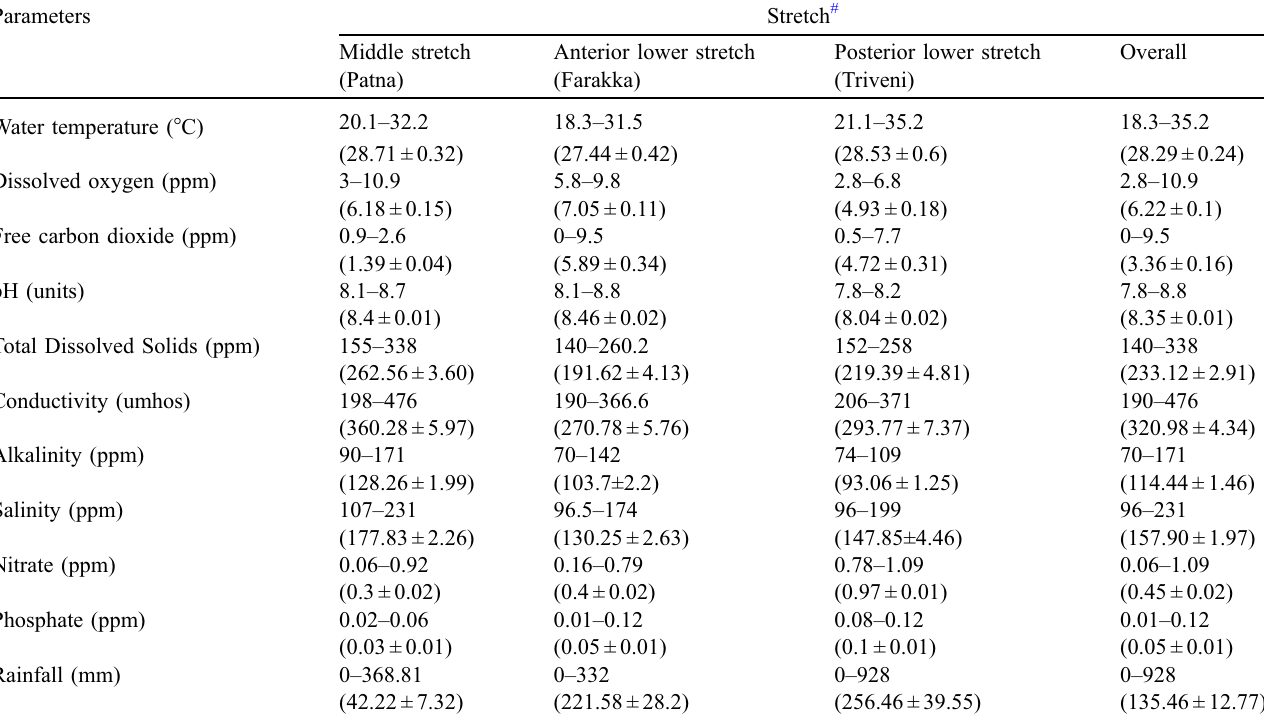
Table 2. Habitat parameters recorded in river Ganga during the study